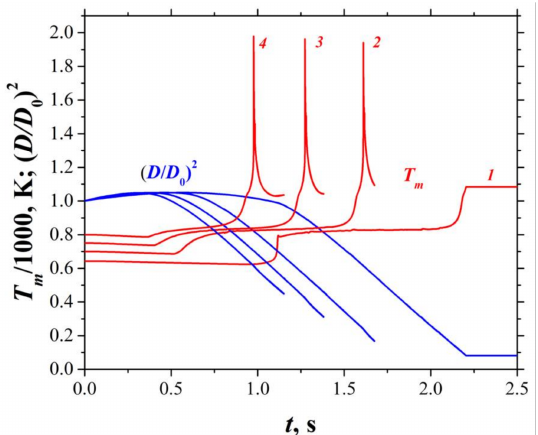
Figure 15. Calculated time histories of the maximum gas temperature, T m , and the normalized squared droplet diameter, D 2 / D 2 , at self-ignition of the n-dodecane droplet with D 0 = 0.7 mm in air 0 at T g 0 = 643 (curve 1), 700 (2), 750 (3), and 800 K (4), and P = 1 bar.